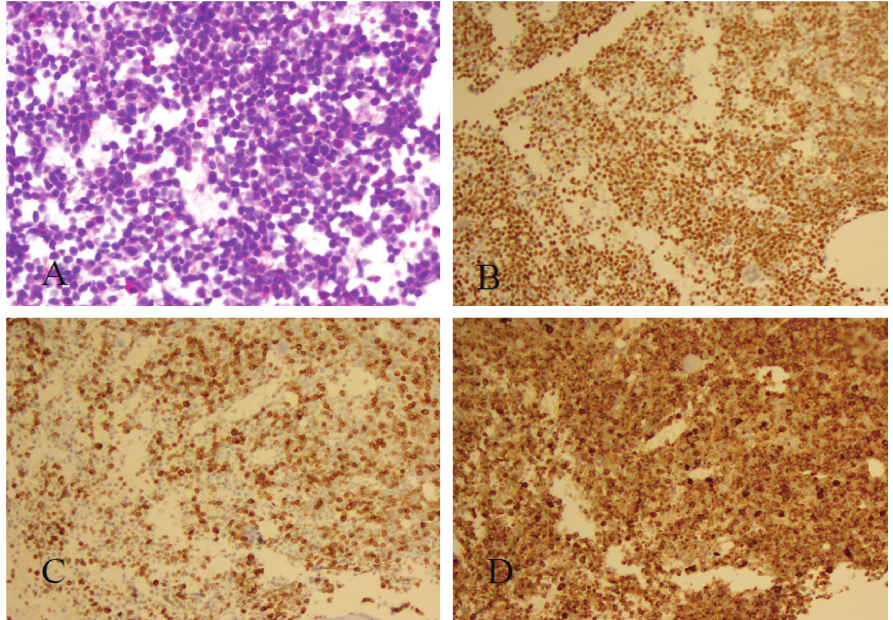
Figure 1: Bone marrow biopsy with T/myeloid mixed-phenotype acute leukemia as demonstrated by H&E stain with 80% blasts. (a) 200x and immunohistochemical stains for terminal deoxynucleotidyl transferase. (b) DAB, 200x, cytoplasmic CD3 with anti-CD3 (2GV6) rabbit monoclonal antibody against the epsilon chain. (c) DAB, 200x, and myeloperoxidase. (d) DAB,